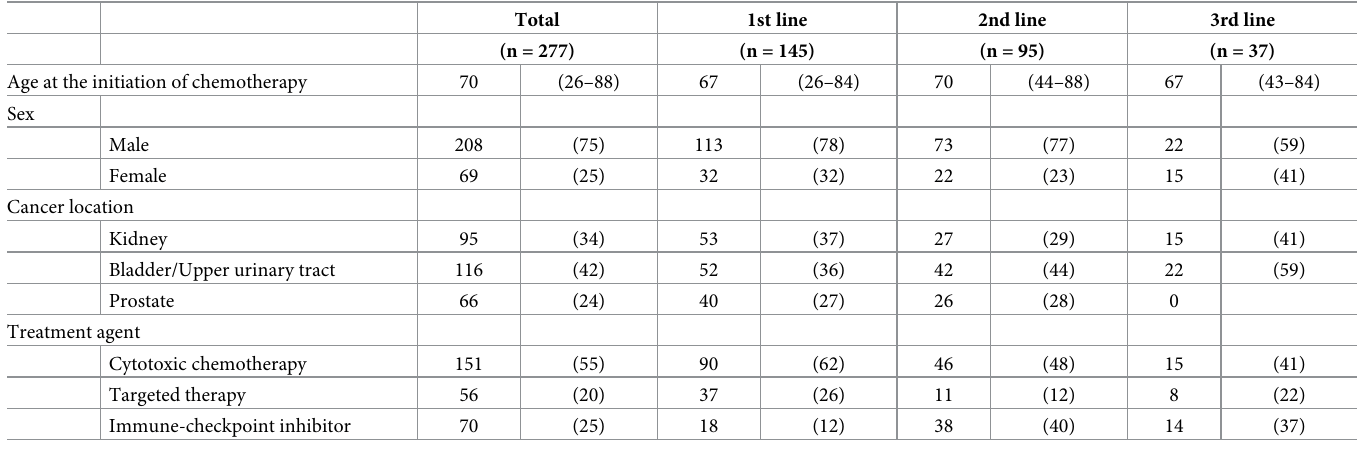
Table 1. Patient